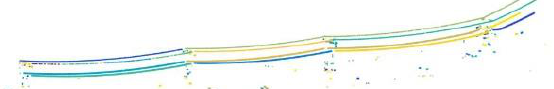
Figure 9. Linear element extraction result (colored by element).